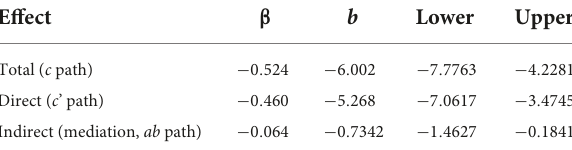
TABLE 8 Mediation effects of distress on the relationship between pain interference and ADLs controlling for age, N =